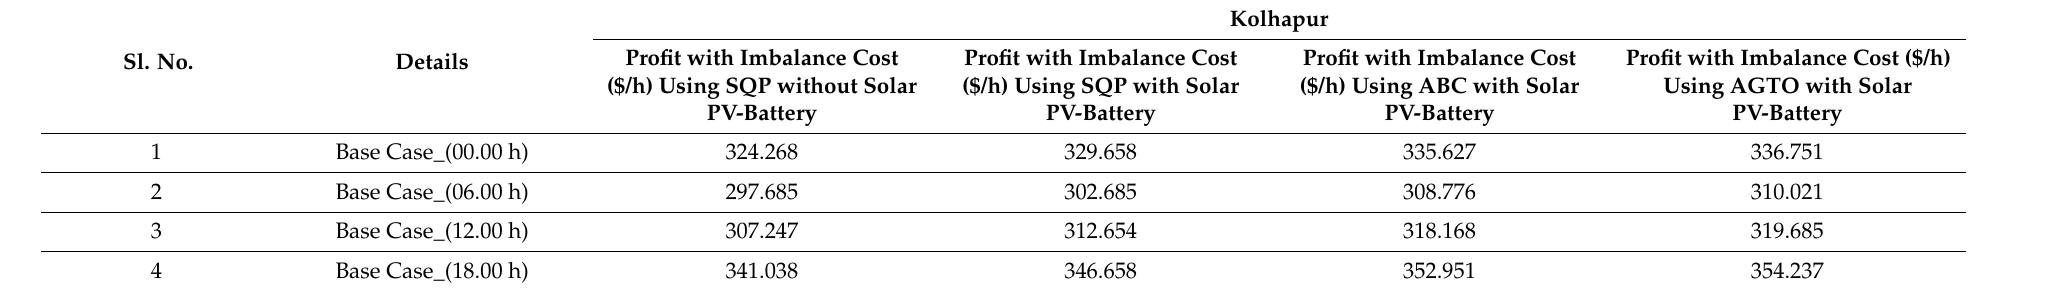
Table 9. System profit with different optimization techniques (for Kolhapur).